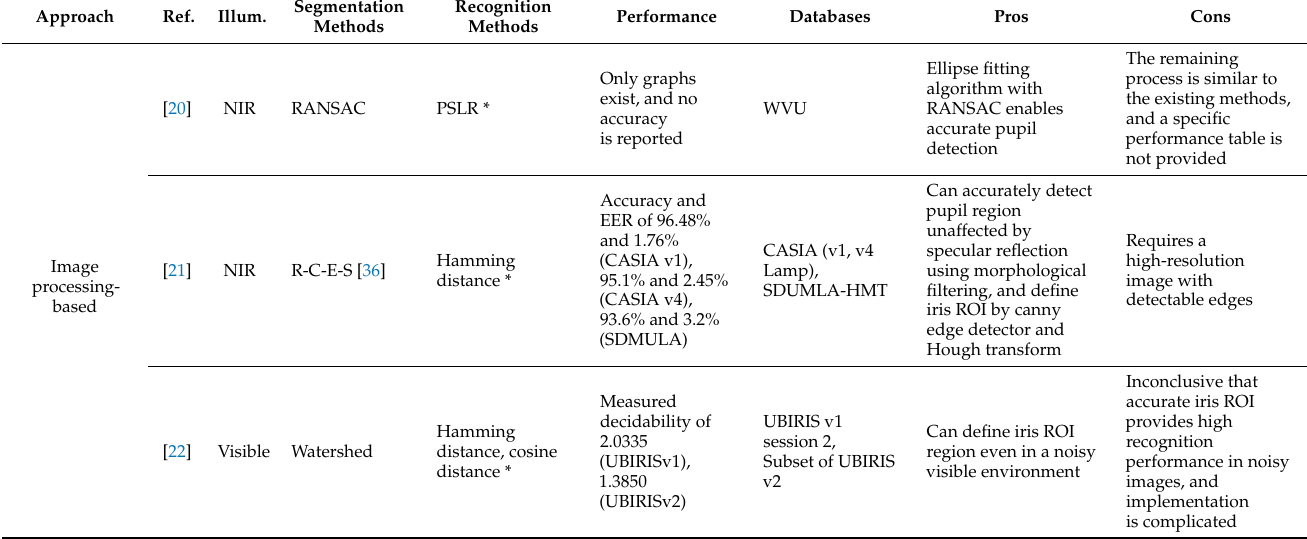
Table 1. Research into iris recognition with high-resolution images (* means that Daugman’s rubber- sheet model is used for iris region normalization); (Ref. and Illum. mean reference and illumina- tor,